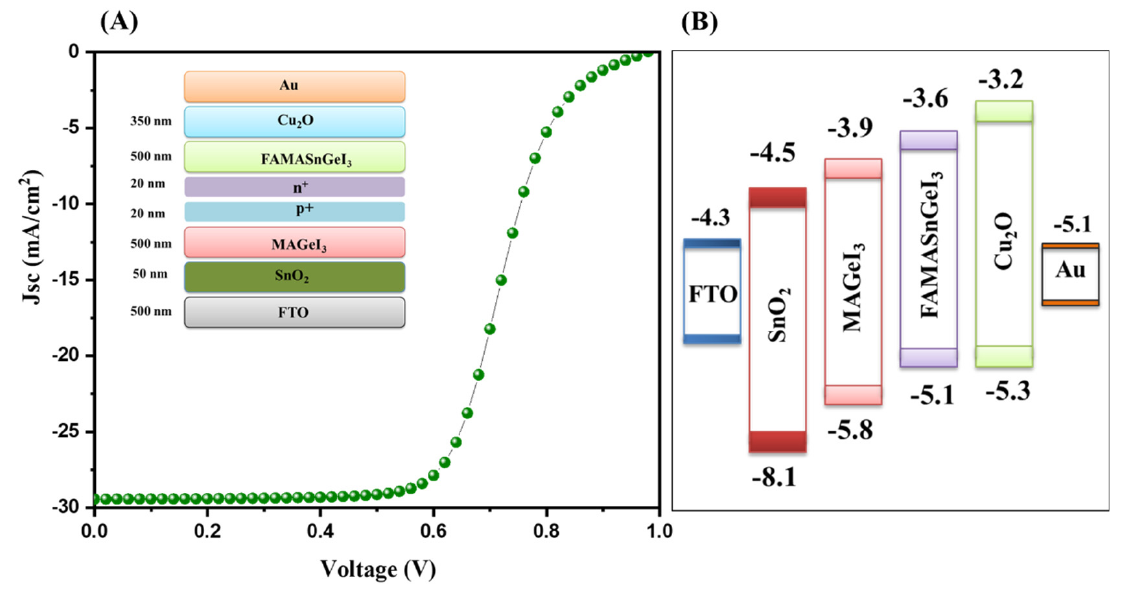
Figure 8. J–V curve ( A ) and energy level diagram ( B ) of tandem solar cells with SnO 2 as the ETL.